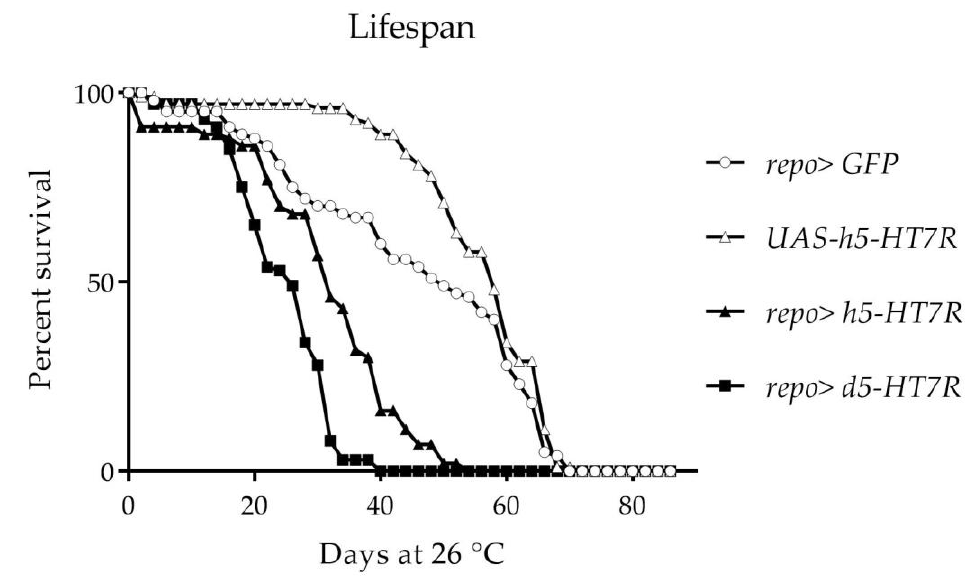
Figure 3. Expression of Drosophila or human 5-HT7 receptor in glial cells reduces lifespan of flies. Controls are repo>GFP and UAS-h5-HT7R. Results correspond to the percent of living flies.